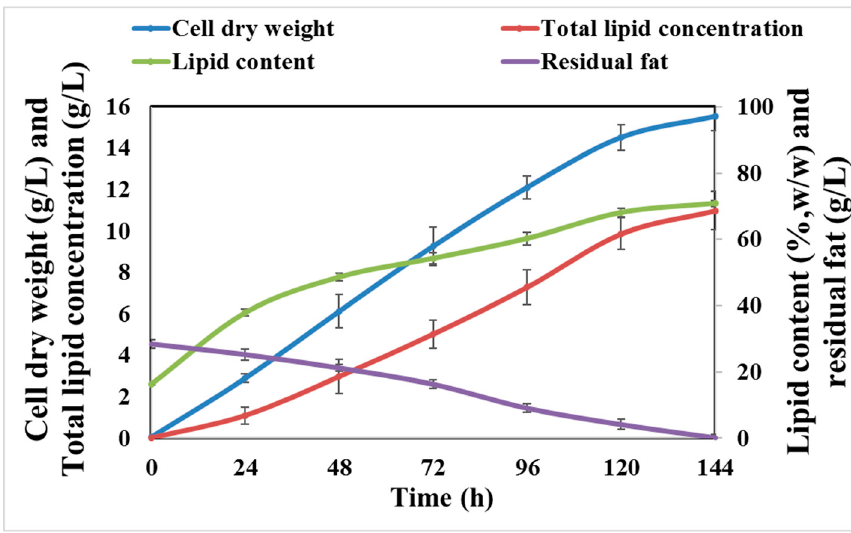
Figure 4. Time course showing changes in the cell dry weight, lipid content, lipid concentration, and fat consumption by R. kratochvilovae cultivated in CBM over a period of 144